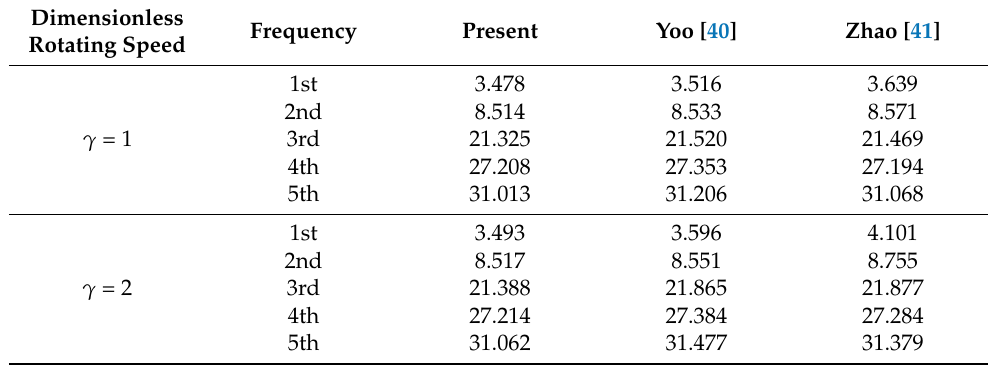
Table 1. Comparison of first five natural frequencies with different rotating speeds. Dimensionless Rotating